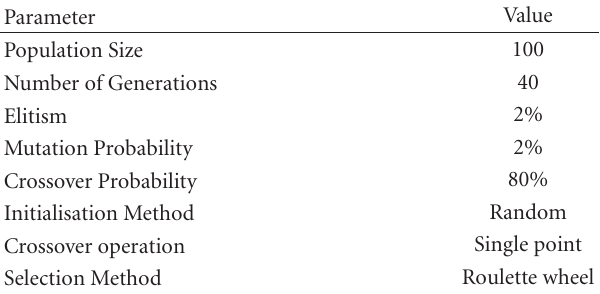
Table 1: GA parameter